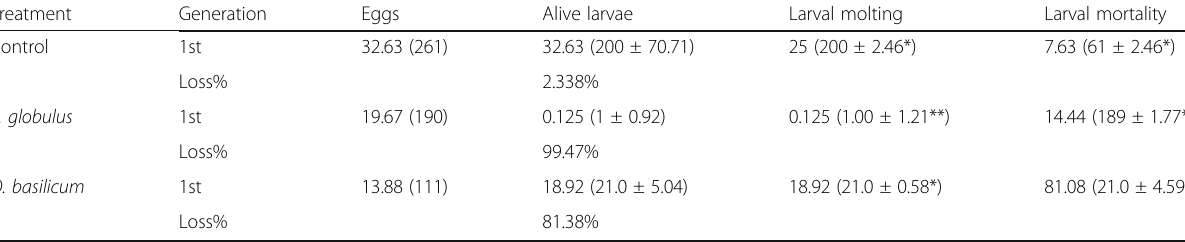
Table 2 Culex pipiens individual numbers under the effect of oils of Eucalyptus globulus and Ocimum basilicum for eight days